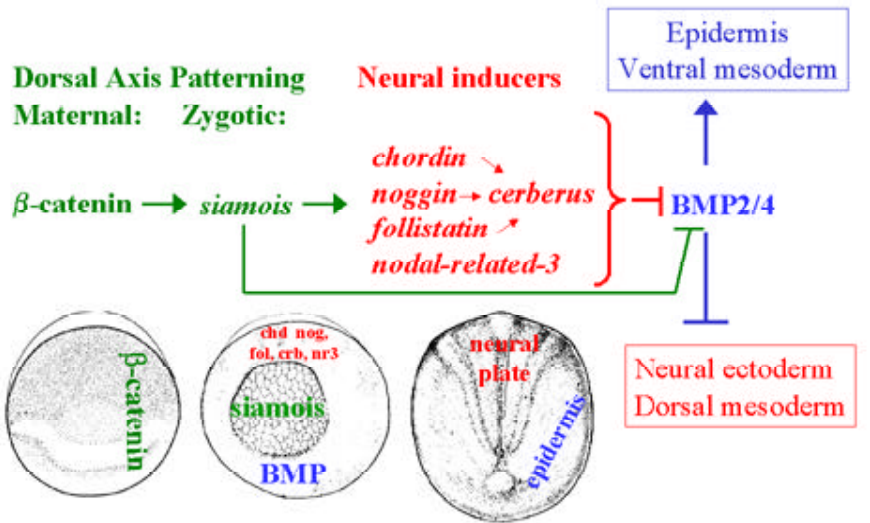
FIGURE 2. The neural inductive signaling pathway is diagrammed. Just after fertilization, maternal b -catenin protein is concentrated on the dorsal side of the egg. One of its downstream targets is Siamois, a zygotically transcribed transcription factor expressed in the dorsal endoderm. Siamois activates the transcription of organizer-specific neural-inducer genes (in red) and represses the transcription of BMP2/4 (blue). The neural inducers are secreted proteins that inhibit BMP signaling. BMP signaling promotes epidermal and ventral mesodermal fates, and represses neural ectodermal and dorsal mesodermal fates. Neural ectoderm is formed when BMP signaling is prevented. Drawings of Xenopus embryos from [139].